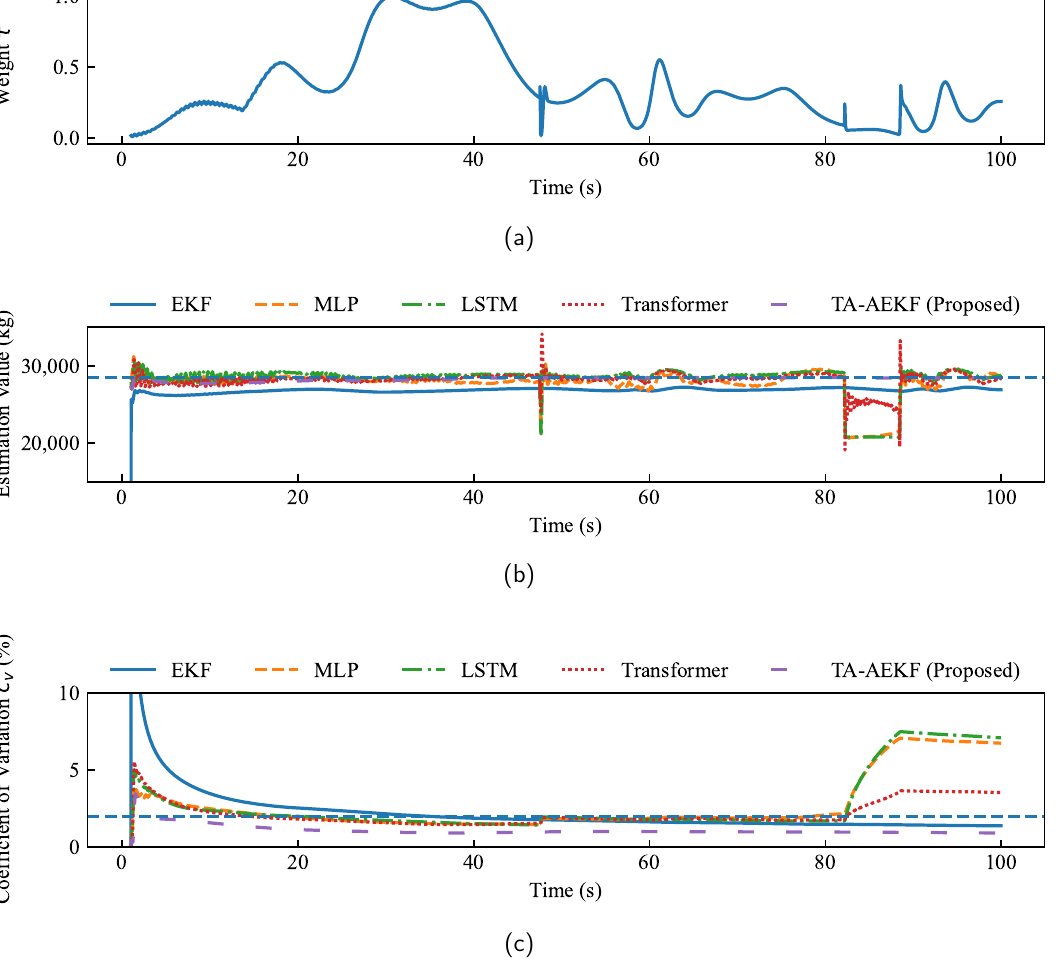
Figure 8. Simulation result of test 2: ( a ) Weight calculation. ( b ) Estimation value of mass. The blue dashed line represents the result of ground truth. ( c ) Evaluation with c v . The blue dashed line represents c v 0 =